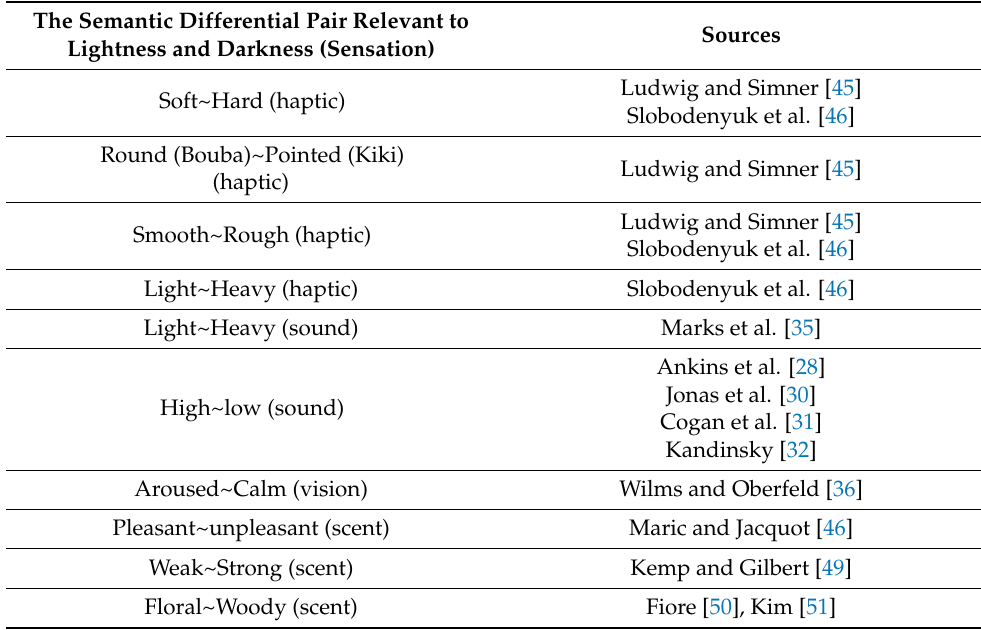
Table 5. Semantic differential association between color lightness and various